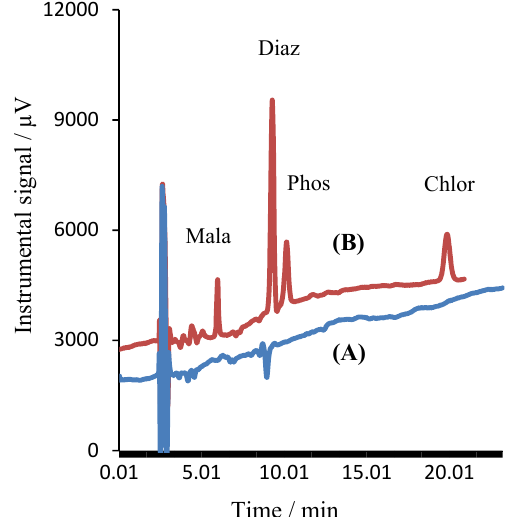
Fig. 6: SPE–HPLC–UV chromatograms: (A) Well water sample; (B) Well water sample spiked with 5 ng mL –1 Phos, 5 ng mL –1 Mala, 2 ng mL –1 Chlo and 2 ng mL –1 Diaz obtained for the target analytes using the proposed